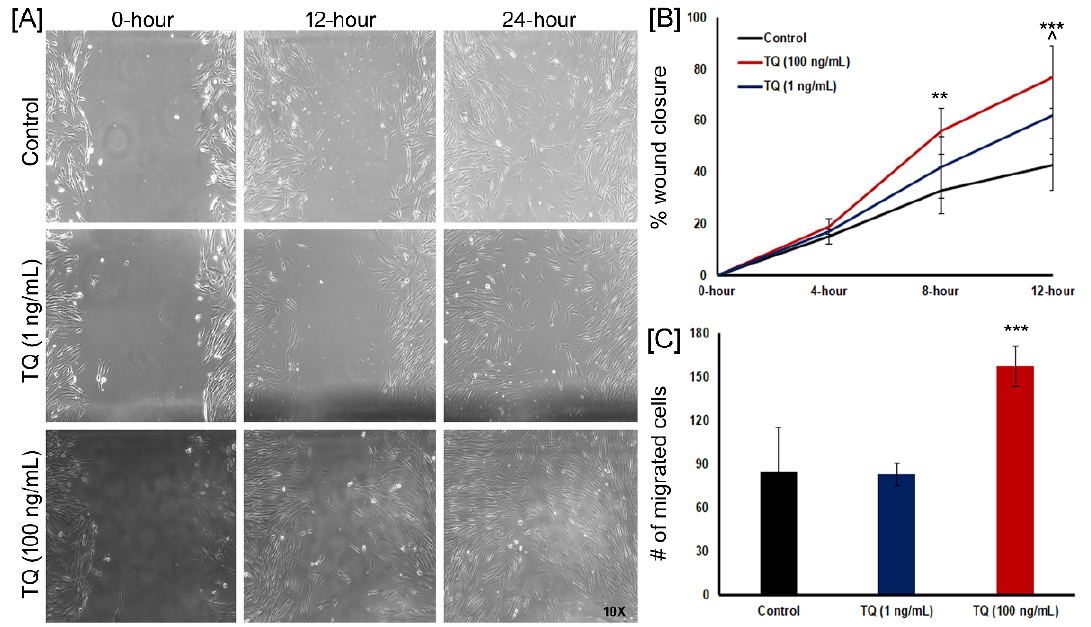
Figure 6. Effect of TQ treatment on the wound healing of human fibroblasts. ( A ) Representative micrographs (10×) from fibroblast cell migration including different treatment groups (Control, 1 ng/mL, and 100 ng/mL of TQ) showing the original wound and the wound after 12 h and 24 h; ( B ) Quantitative analysis of wound closure as a function of time. The wound area was determined as the wound area at a given time relative to the original wound area ( n = 6). ** p < 0.01 and *** p < 0.001 (Control vs. 100 ng/mL) and ^ p < 0.05 (Control vs. 1 ng/mL); ( C ) Quantitative measurement of cell number migrating in the corresponding scratched wound areas at 24 h in the different treatment groups ( n = 6). *** p < 0.001 (100 ng/mL vs. control and 1 ng/mL).